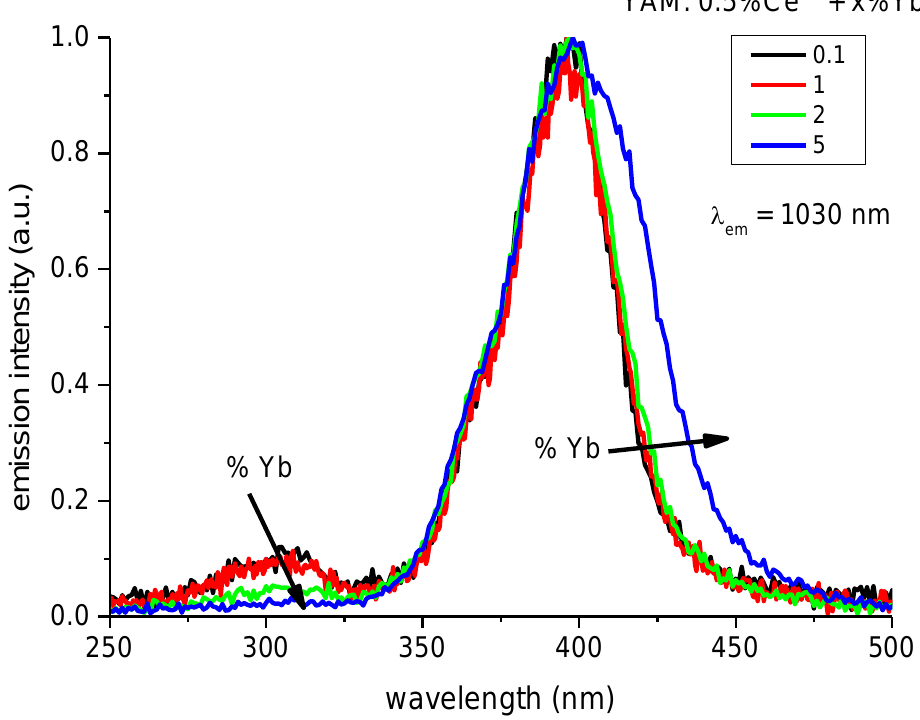
Figure 5. Excitation spectra of Yb 3+ emission monitored at 1030 nm. With the increased concentration of Yb 3+ the relative intensity of peak attributed to Ce 3+ at about 300 nm decreases. Figure 6 shows the emission spectra of the YAM: 0.5% Ce 3+ in the 900–1150 nm NIR range for various concentrations of the Yb 3+ ions co-dopants. The spectra are normalized to emission intensity at 1030 nm. Increasing concentration of Yb 3+ ions weakens the emis- sion peak at 973 nm, due to reabsorption caused by the partial overlap of this peak emis- sion and Yb 3+ excitation. While the most beneficial shape of the Yb 3+ emission is obtained for its lowest concentration of just 0.1% it does not necessarily mean that this would be the optimal concentration for the solar modifying layer of a solar cell, as the trade-off be- tween spectral mismatch, and the absorbance of such a layer, also depends on the layers, geometry, and properties of the considered solar cell.